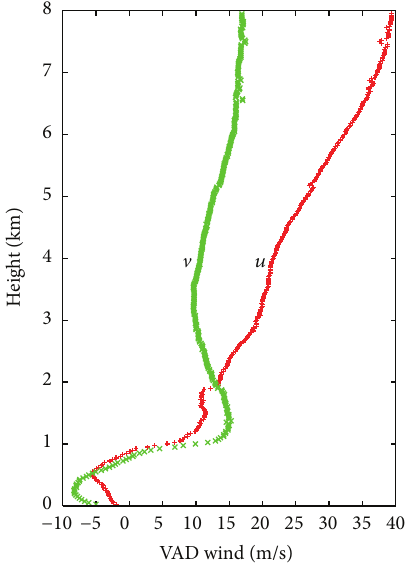
Figure 5: Vertical profiles of zonal and meridional components, (𝑢, V ) , of VAD wind produced from the dealiased radial velocities for the ice storm case in Figure